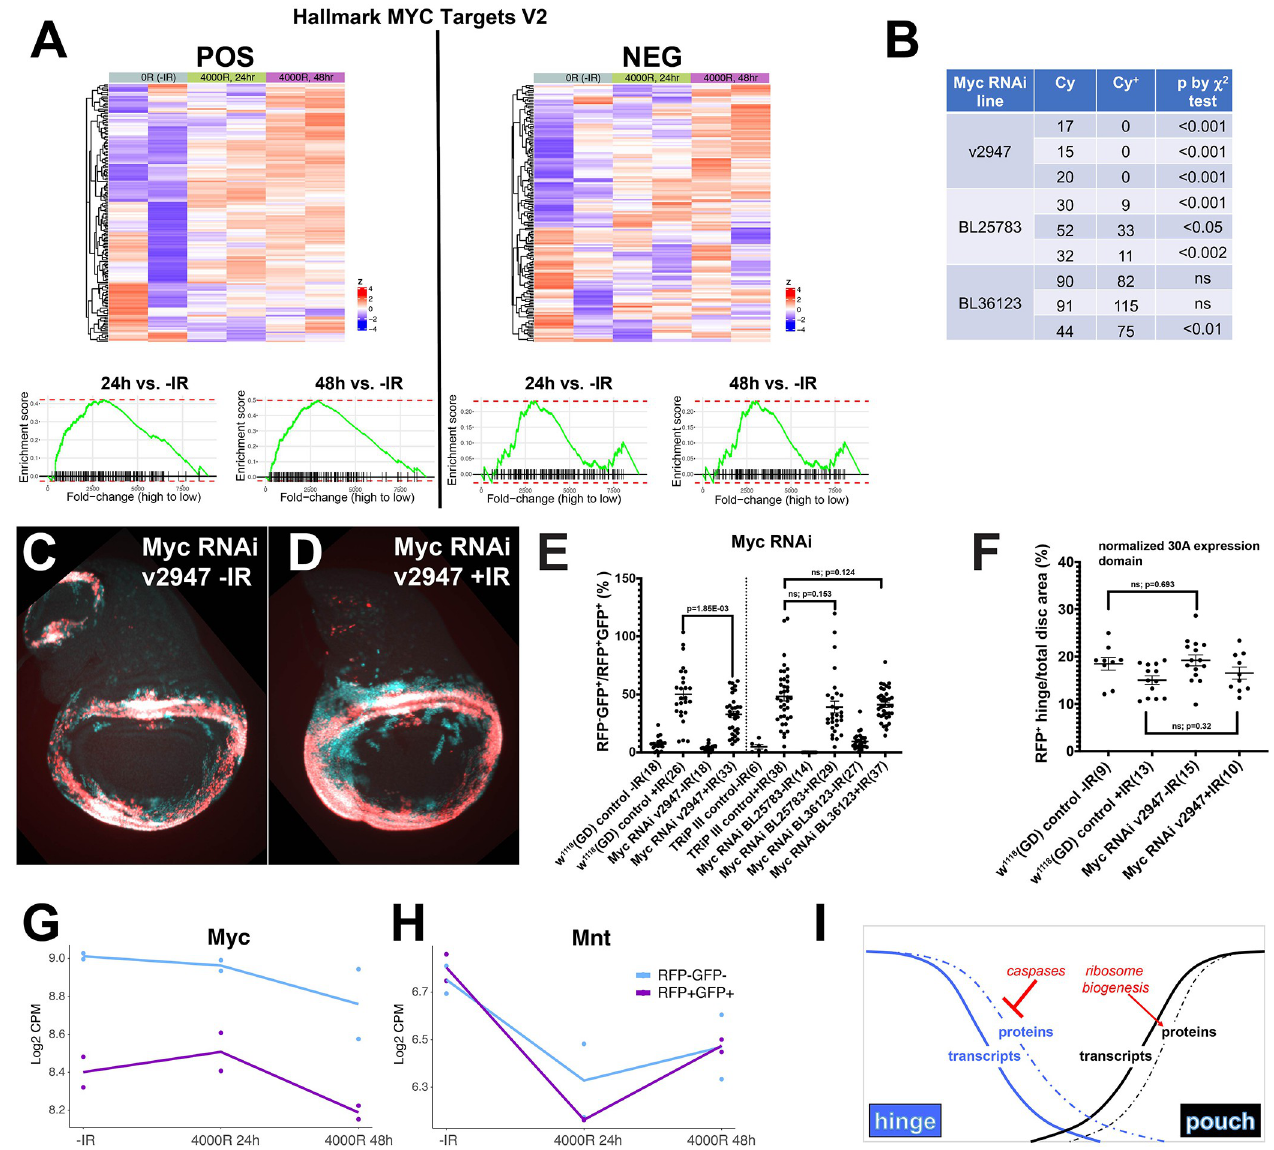
Fig 6. The role of Myc in fate change. (A) Heatmaps displaying Myc targets in POS and NEG cells. Gene names are in S2 Table. Gene set enrichment plots for indicated differential expression comparisons are shown below. The fold-change is ranked from high to low, so higher in 24h or 48h compared to -IR. (B) The potency of RNAi constructs was assessed in terms of lethality when constitutively expressed (without GAL80 ts ) from en-GAL4, using the X 2 test. One parent in each cross was balanced over CyO so that expected ratio if RNAi had no effect was 1 Cy:1 Cy + . v2947 produced complete lethality, BL25783 was partially lethal and BL36123 had no effect. The data from three independent egg collections for each RNAi line are shown. (C-D) Representative wing discs expressing 30A-GAL4 > Myc RNAi, with and without IR. (E) Fate change in wing discs from larvae expressing 30A-GAL4 > Myc RNAi and treated as in Fig 1G were quantified as in Figs 4 and 5. The results for three RNAi lines were shown next to respective control stocks. Only v2947 reduced fate change significantly. p- values were calculated using a 2-tailed t-test. The numbers in brackets are the total number of discs examined in two or more biological replicate experiments. (F) Under the experimental conditions used to monitor cell fate change, depletion of Myc did not interfere with the formation or growth of the hinge (RFP + domain). p-values were calculated using a 2-tailed t-test. The numbers in brackets are the total number of discs examined in two or more biological replicate experiments. (G-H) Expression trajectories for Myc and its inhibitor Mnt. Pairs of dots represent data from two biological replicates. Lines connect the averages. (I) The model for the role of ribosome biogenesis in fate change.